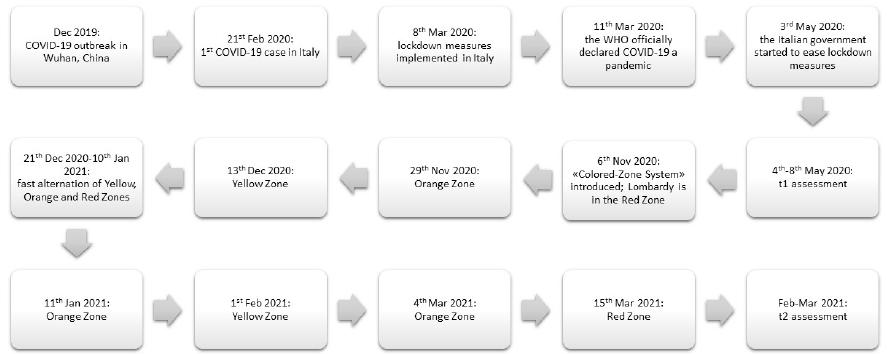
Figure 1. Timeline of the evolution of the COVID-19 pandemic and of the consequent restrictions implemented in Italy during the first and second wave. Since the beginning of the second wave (November 2020), the Italian government implemented a so-called “Colored-Zone System”: every two weeks, the spread of the COVID-19 contagion was evaluated separately in each region of Italy and, according to its severity, different levels of restrictive measures were imposed. In particular, the “Red Zone” corresponded to a complete lockdown; the “Orange Zone” corresponded to mild-to-severe restrictive measures (e.g., it was possible for citizens to move freely only within their town of residency and only between 5 am and 10 pm); the “Yellow Zone” included mild restrictive measures (e.g., everyone could move freely within their own region, but still had to respect the 10 pm–5 am curfew). Wearing a face mask always remained mandatory.